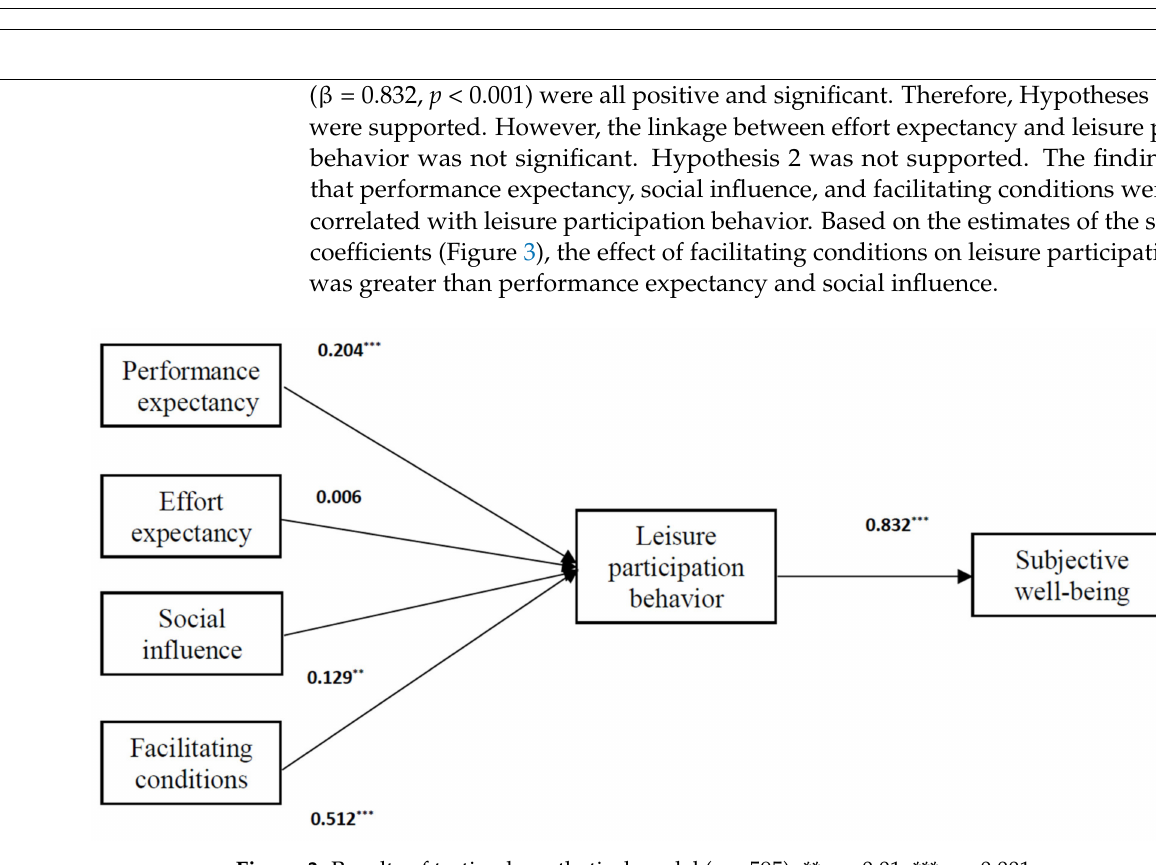
Figure 3. Results of testing hypothetical model ( n = 595). ** p < 0.01, *** p <